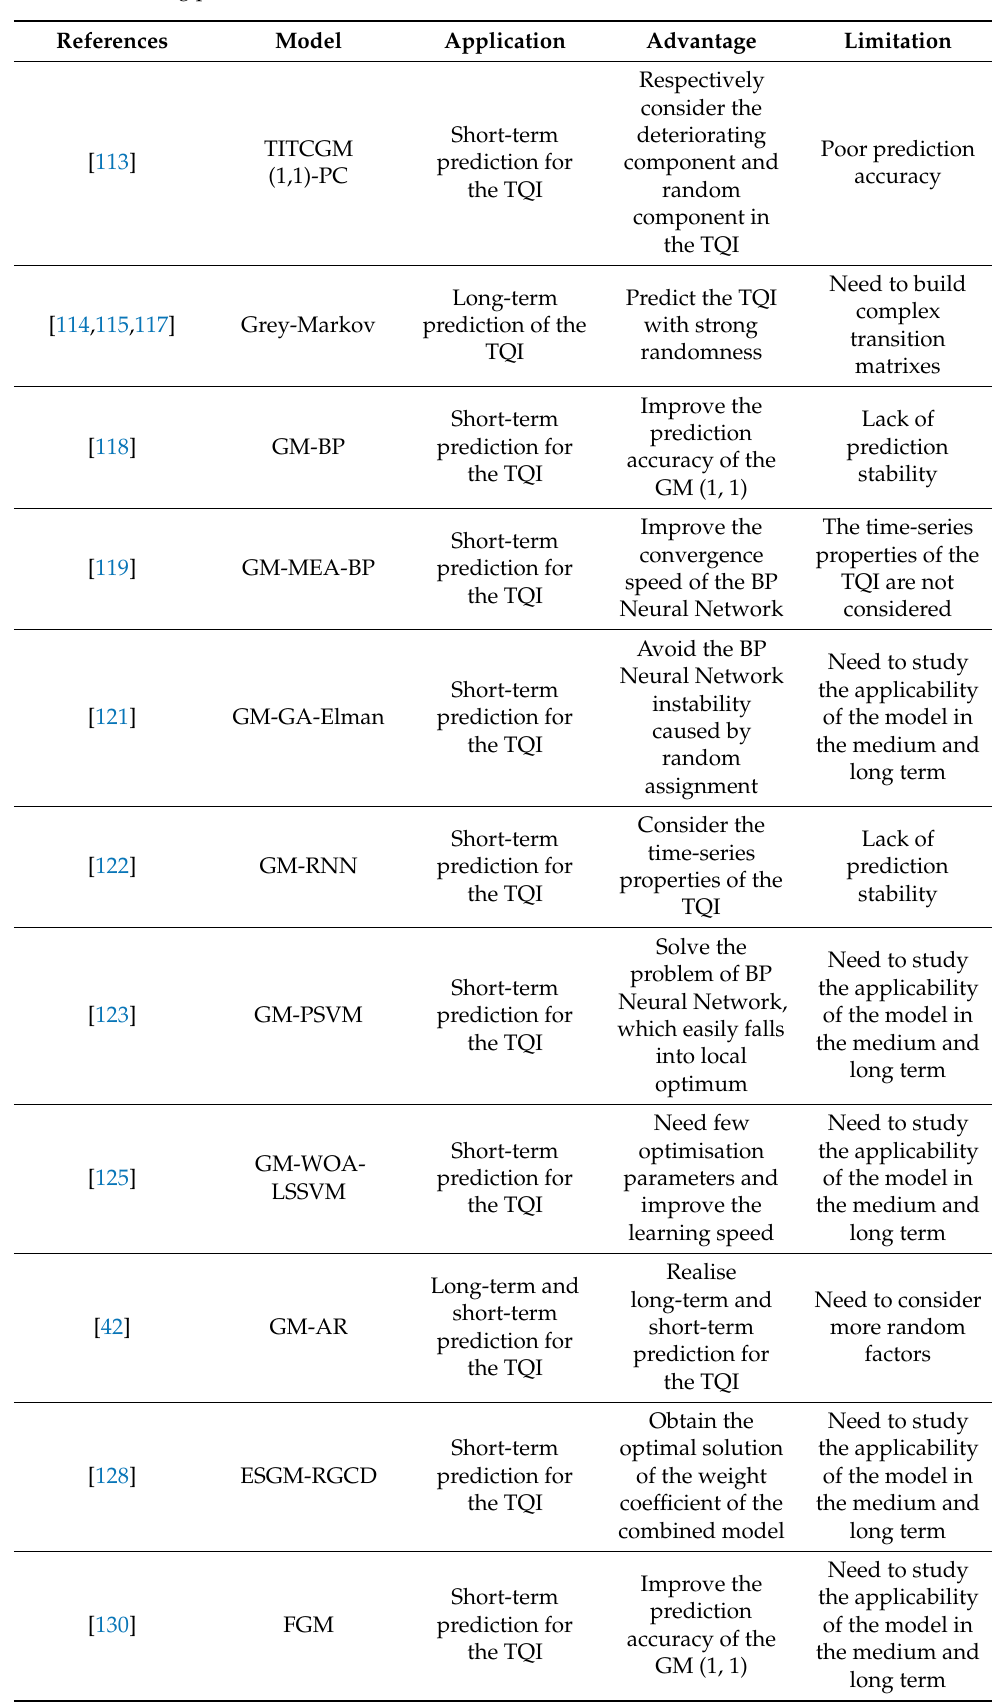
Table 10. Existing predictive models combined GM (1, 1) model and other